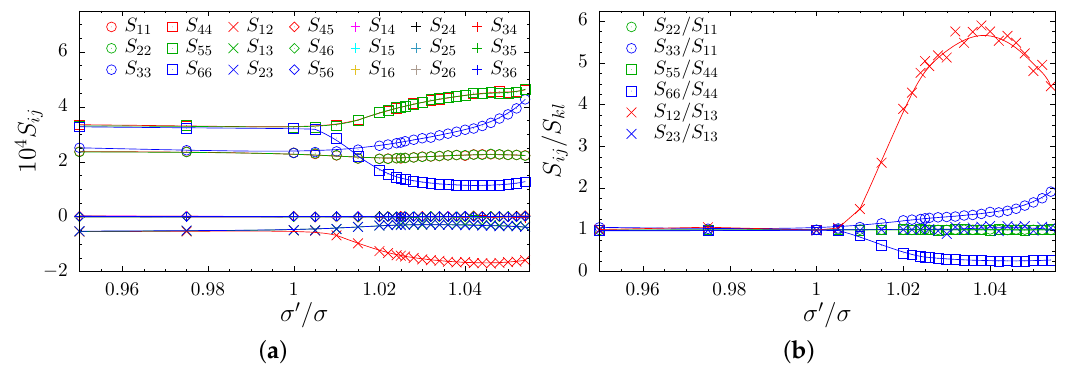
Figure 4. The elastic compliance matrix elements: ( a ) plotted as a function of the σ (cid:48) / σ ratio and ( b ) the selected ratios of elastic compliance elements plotted to show that the respective relations imposed by the symmetry are fulfilled. The lines are drawn to guide the eye.